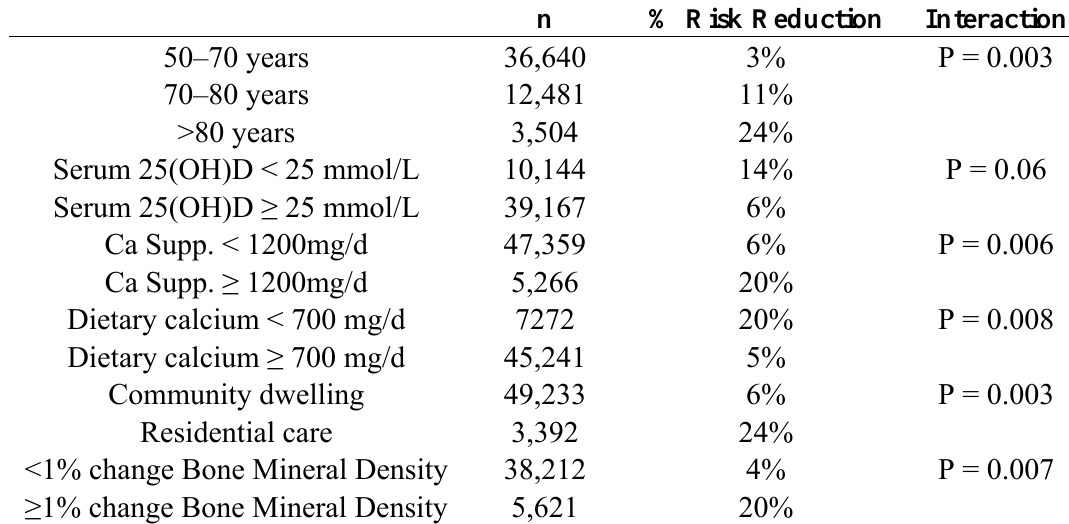
Table 1. Population sub-groups reduction in total fracture risk with calcium supplementation: meta-analysis. Reproduced from [16].